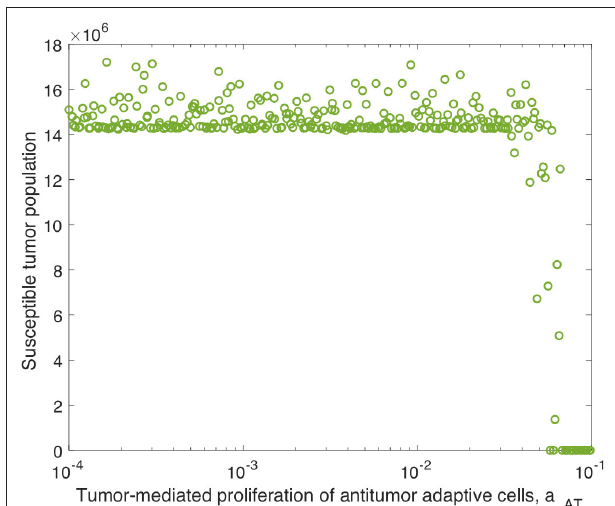
FIGURE 9 | Tumor size in adaptive immune sensitivity analysis with anti-PD-1, as a function of a AT , the tumor-mediated proliferation of tumor-specific adaptive immune cells. We use t = 300 h as the endpoint for the adaptive sensitivity analysis. The PRCC between a AT and the susceptible tumor population is ˆ P ( a AT ,300) = − 0.3213.